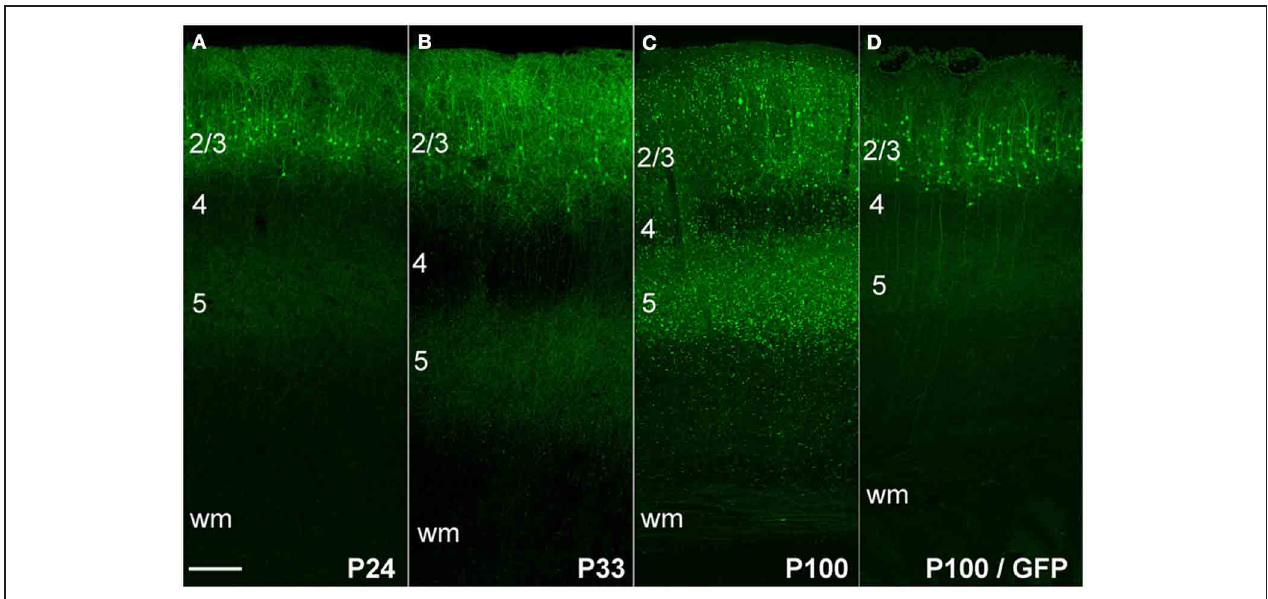
Increasing appearance of abnormal EYFP + puncta at P33 and P100. (D) Absence of puncta in a rat electroporated with GFP instead of ChR2 (age: P100). Scale bar, 200 μ m. Numbers indicate cortical layers. wm, white